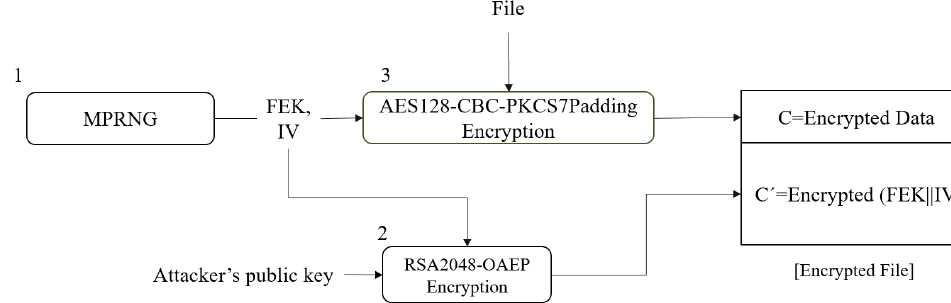
Figure 2. Encryption process of Magniber